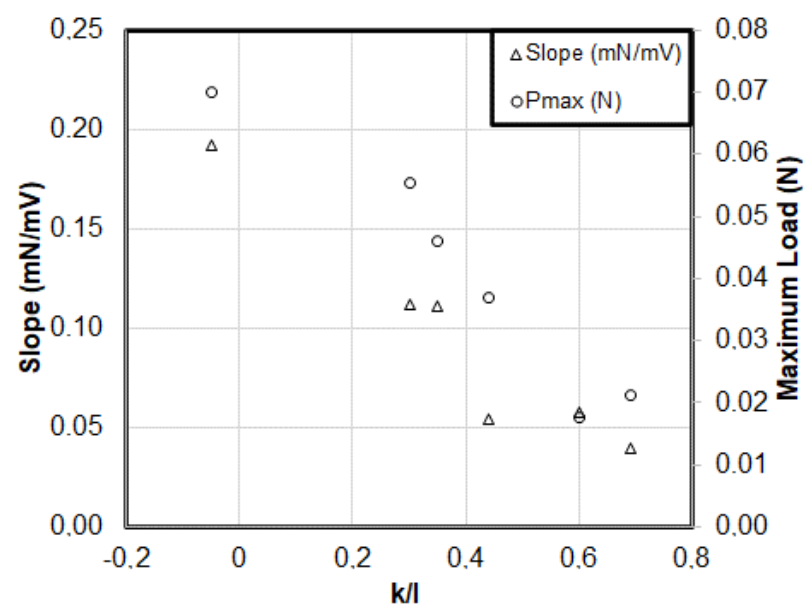
Figure 8. Slope and maximum load versus embedment ratio.